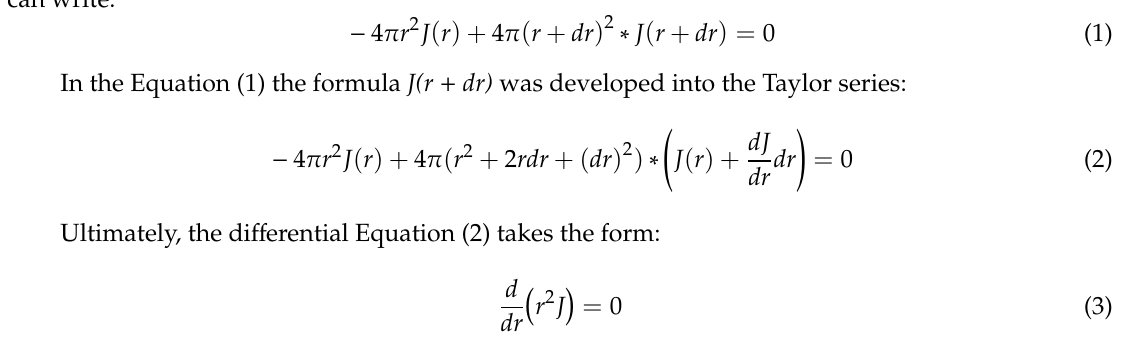
Figure 3. Schematic representation of grain growth with radius r.